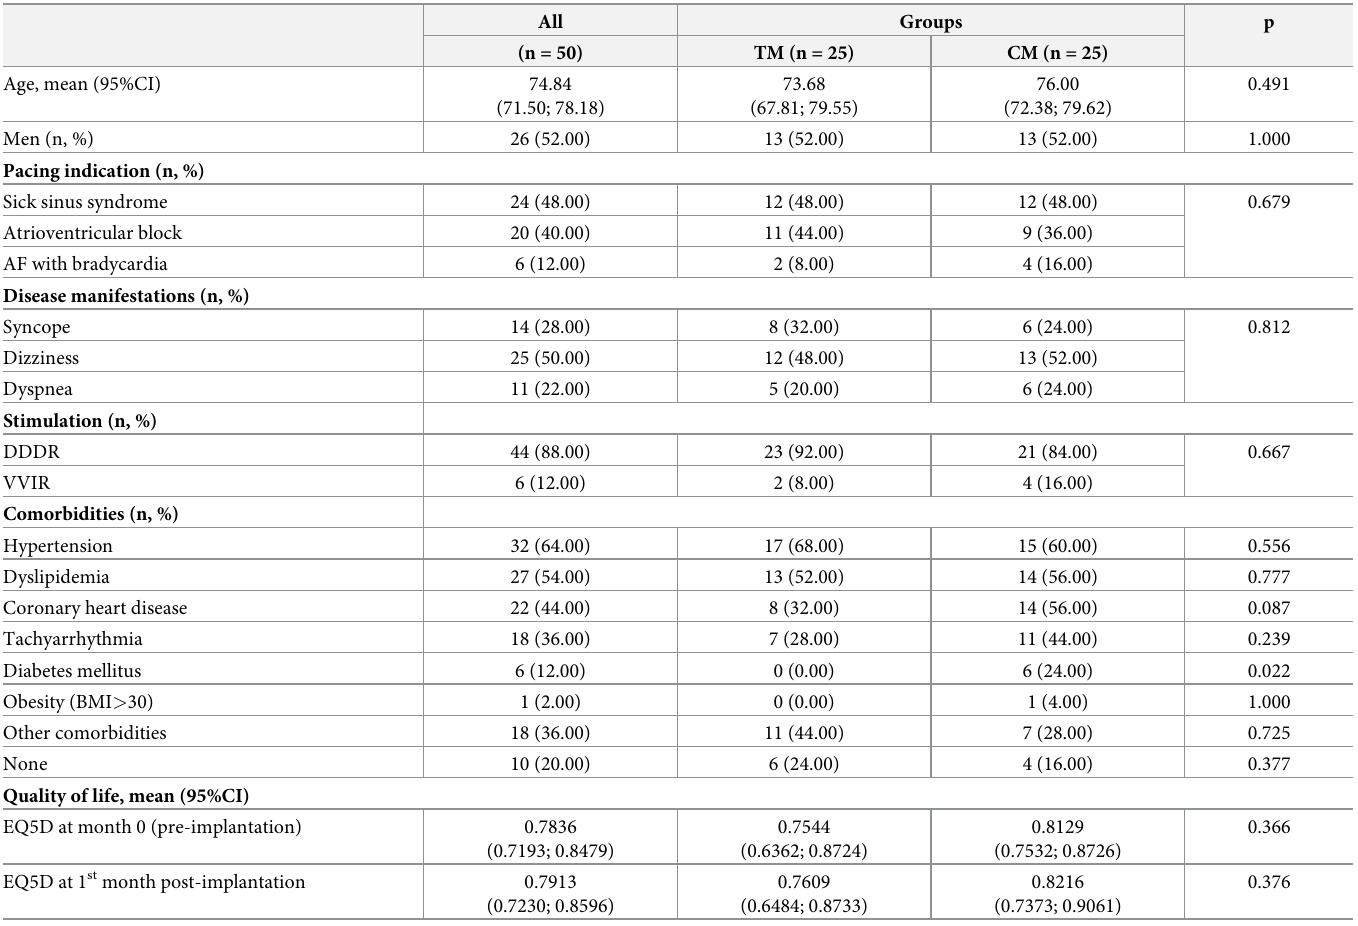
Table 1. Patients’ clinical characteristics at